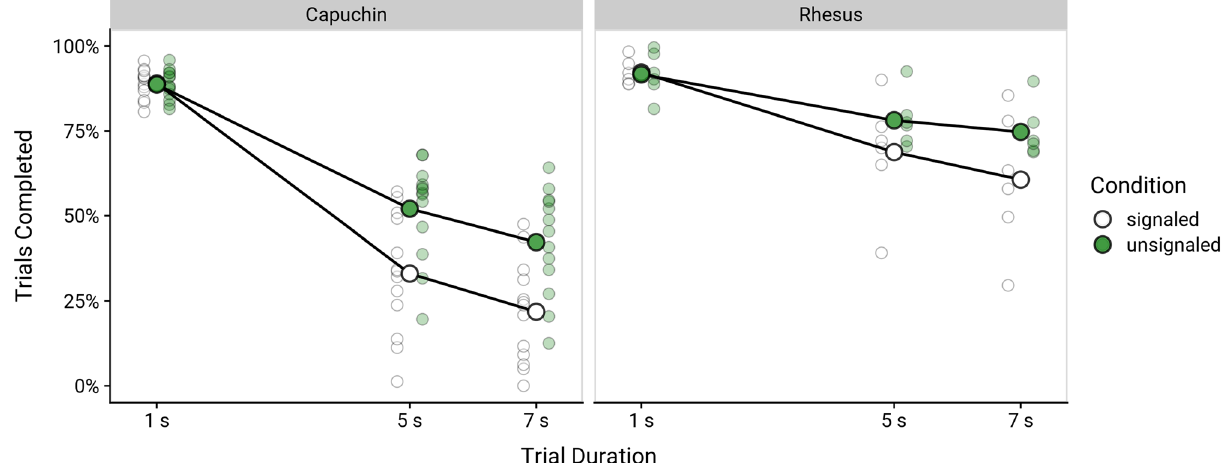
Figure 2. Trial completion by species, trial duration, and condition. Small transparent points indicate individual monkeys; large points connected by lines indicate group means.